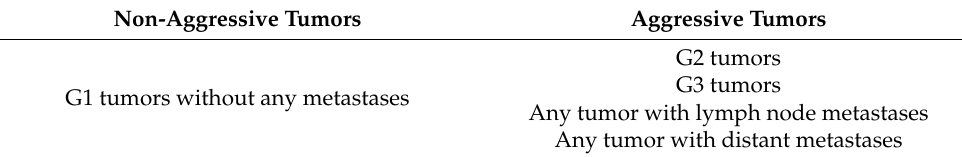
Table 2. Division of tumors into two groups according to aggressiveness. Non-Aggressive Tumors Aggressive